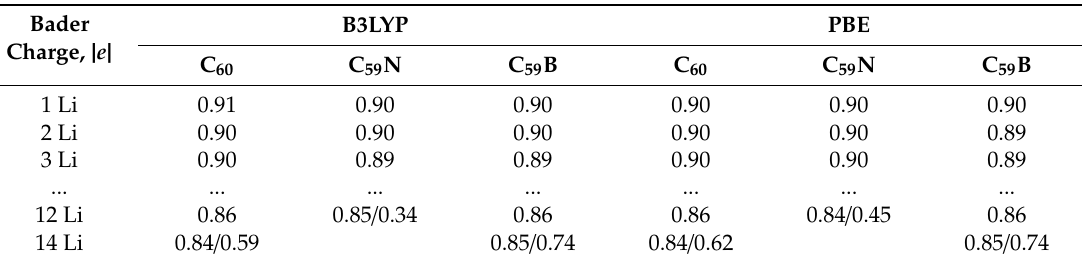
Table 1. Bader charges on Li atoms for attachment of di ff erent numbers of Li atoms to C 60 , C 59 N, and C 59 B computed with B3LYP and PBE functionals. Average charge per Li is given when the charges are similar among Li atoms, and the charge of the last Li attached is shown after “ / ” when it is significantly di ff erent from the average of charges of all other Li